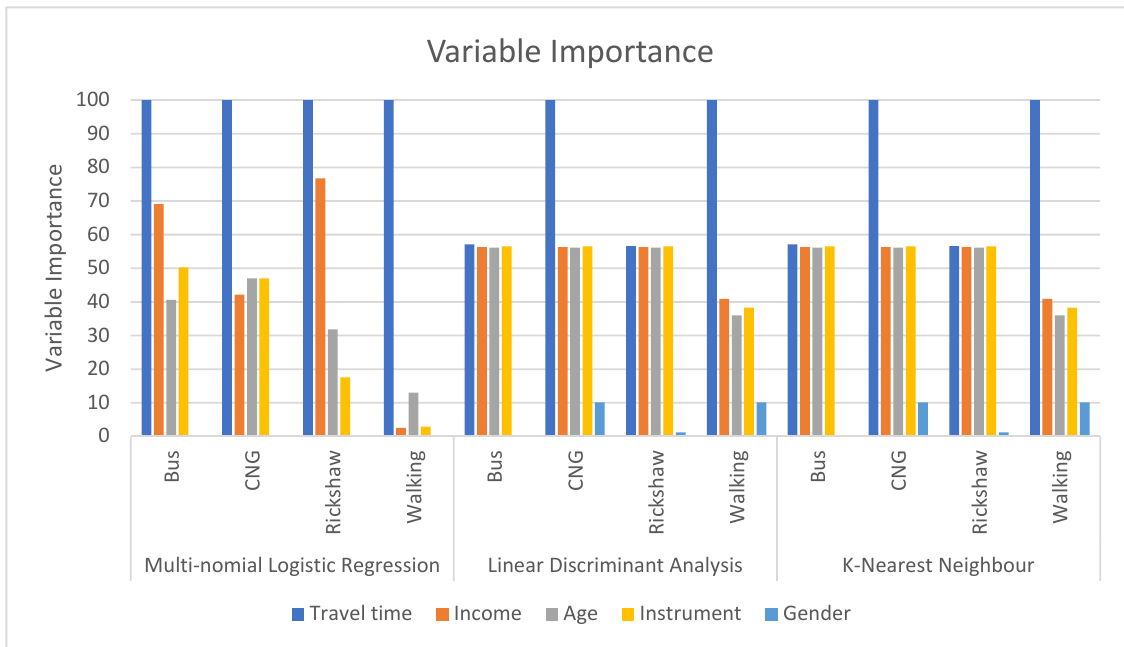
Figure 6. Variable importance for MNL, LDA, and KNN.